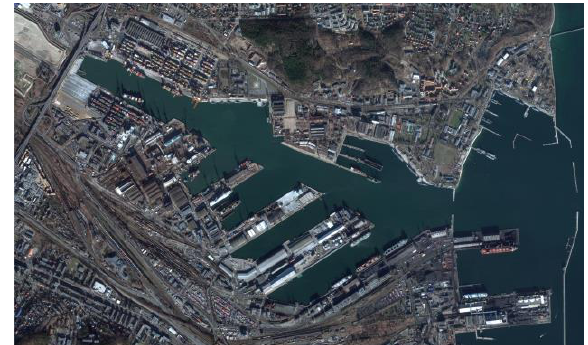
Figure 4. Gdynia Port in Poland